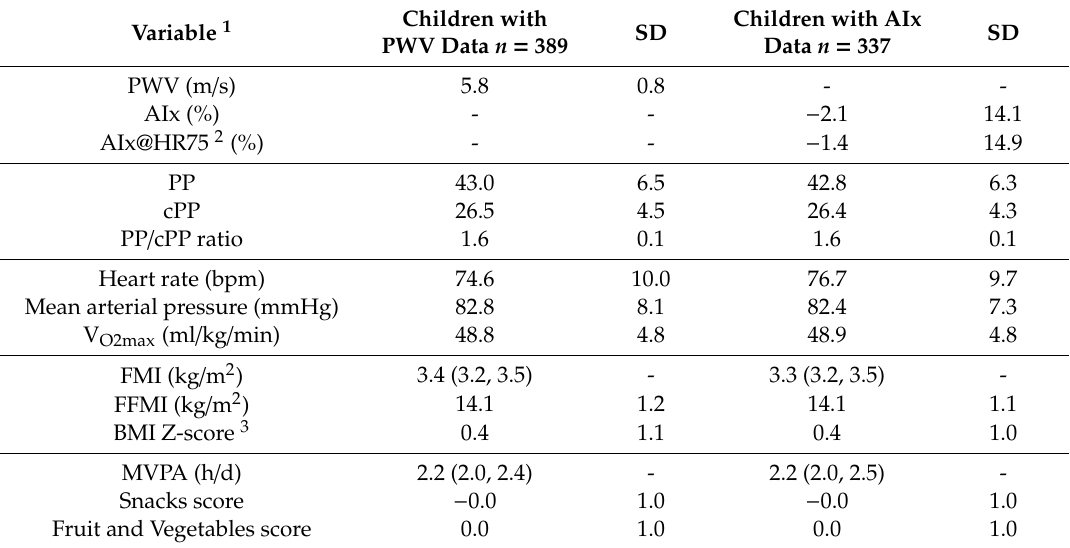
Table 2. Physiological, anthropometric and lifestyle covariates in children with PWV or AIx data. Children with Variable 1 PWV Data n =